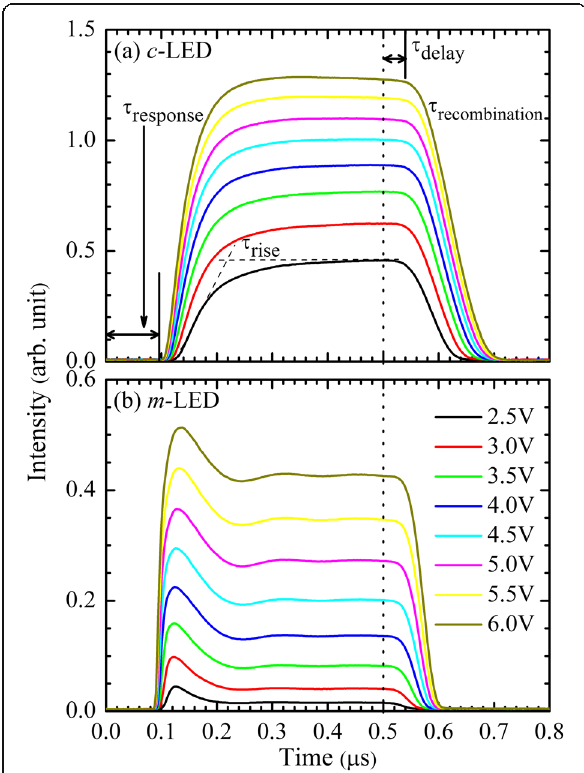
Fig. 4 TREL transit profiles for the ( a ) c - and ( b ) m -plane LEDs, with the vertical dotted line indicating the pulse voltage switching off. Response ( τ response ), rise ( τ rise ), delay ( τ delay ), and recombination ( τ recombination ) times are shown in a